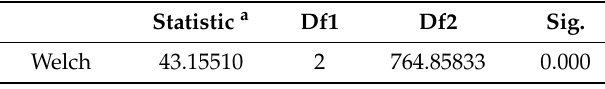
Table 3. Results obtained from the Games–Howell post-hoc test.